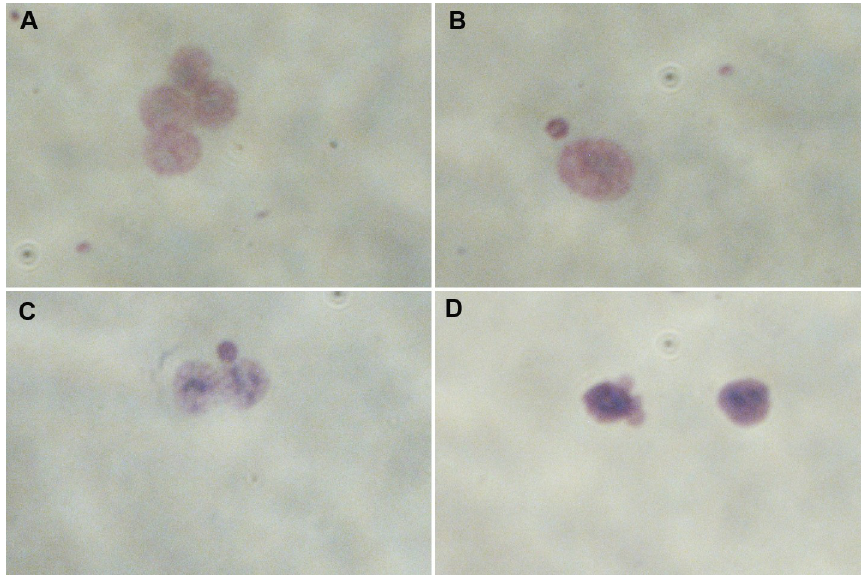
Fig 7. Cytokinesis-Block Micronucleus cytome (CBMN cyt) assay in HCT116 cells. DNA damage after PNPs exposure, (A) Control cells, (B) mononucleated cell with MN, (C) binucleated cell with MN and (D) nuclear blebs. Magnification